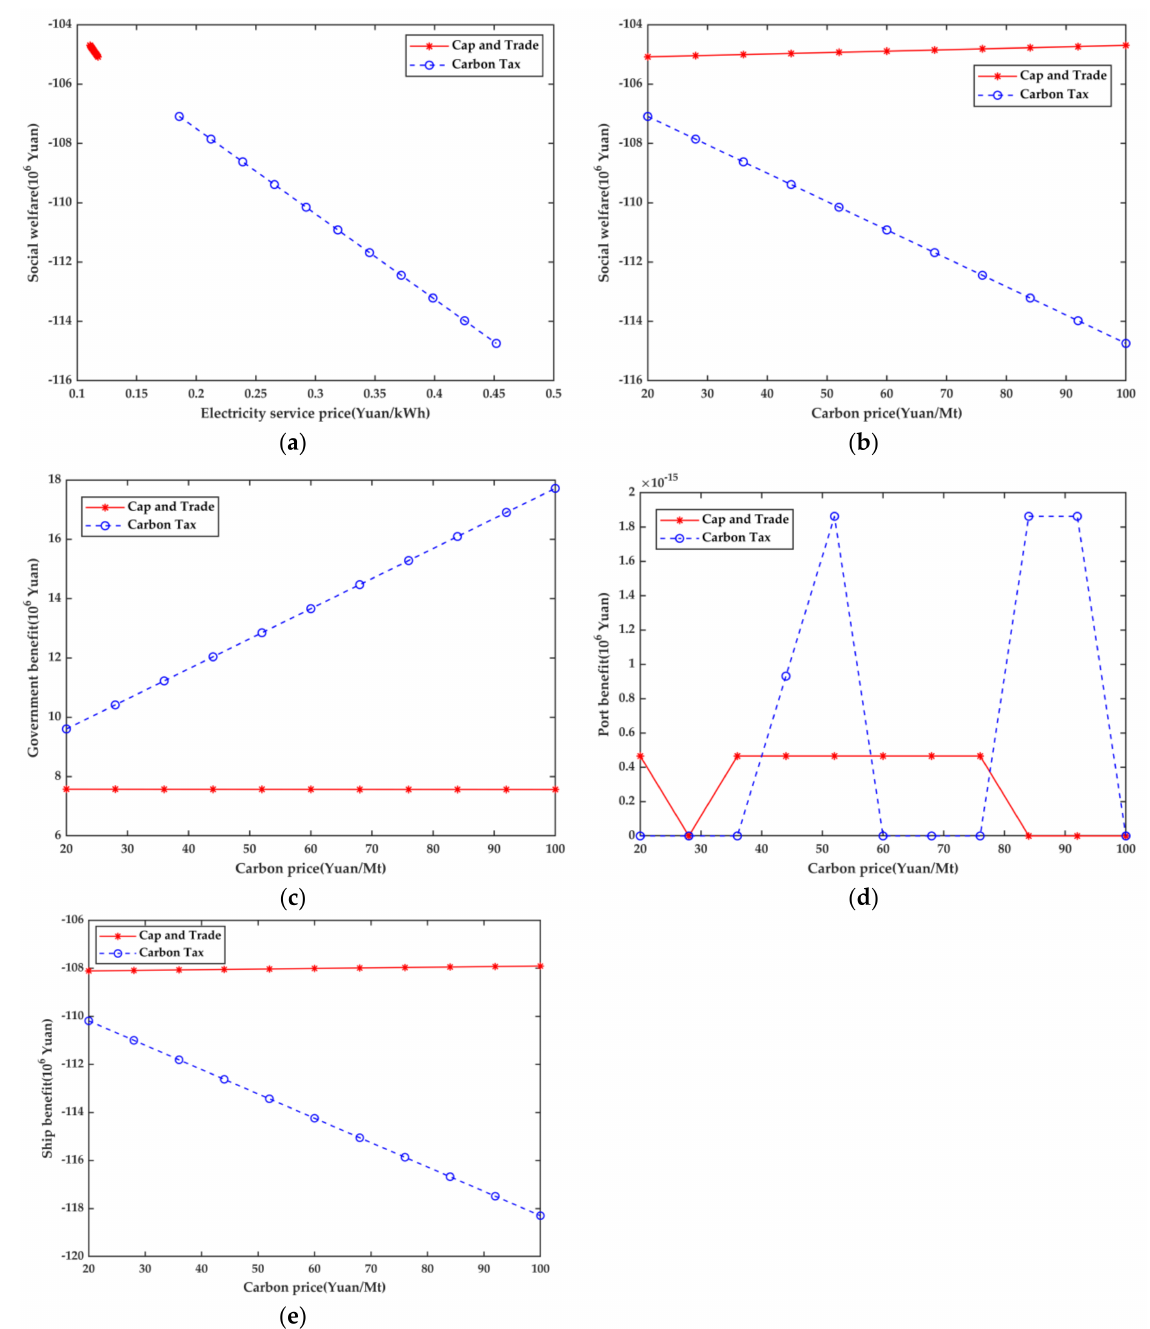
Figure 7. The relationship between carbon price and the benefits to all parties. ( a ) The relationship between electricity service price and social welfare; ( b ) The relationship between carbon price and social welfare; ( c ) The relationship between carbon price and government benefit; ( d ) The relationship between carbon price and port benefit; ( e ) The relationship between carbon price and ship